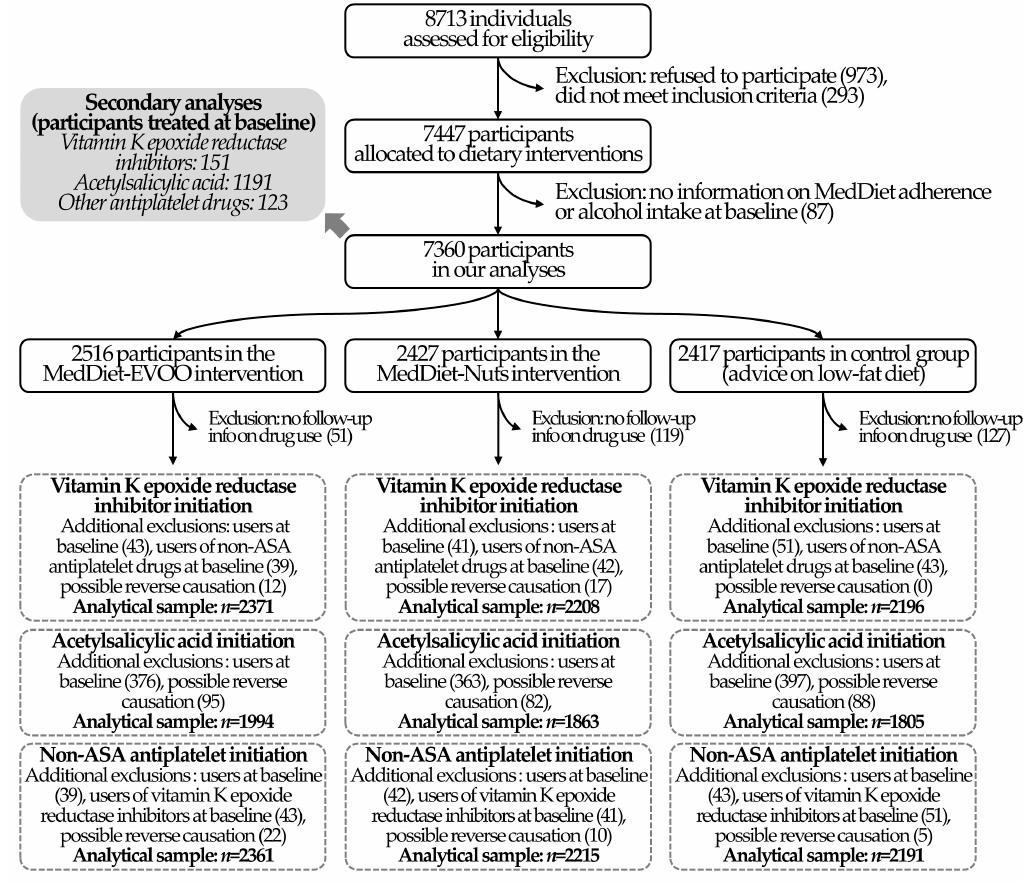
Figure 1. Flow chart of the study.